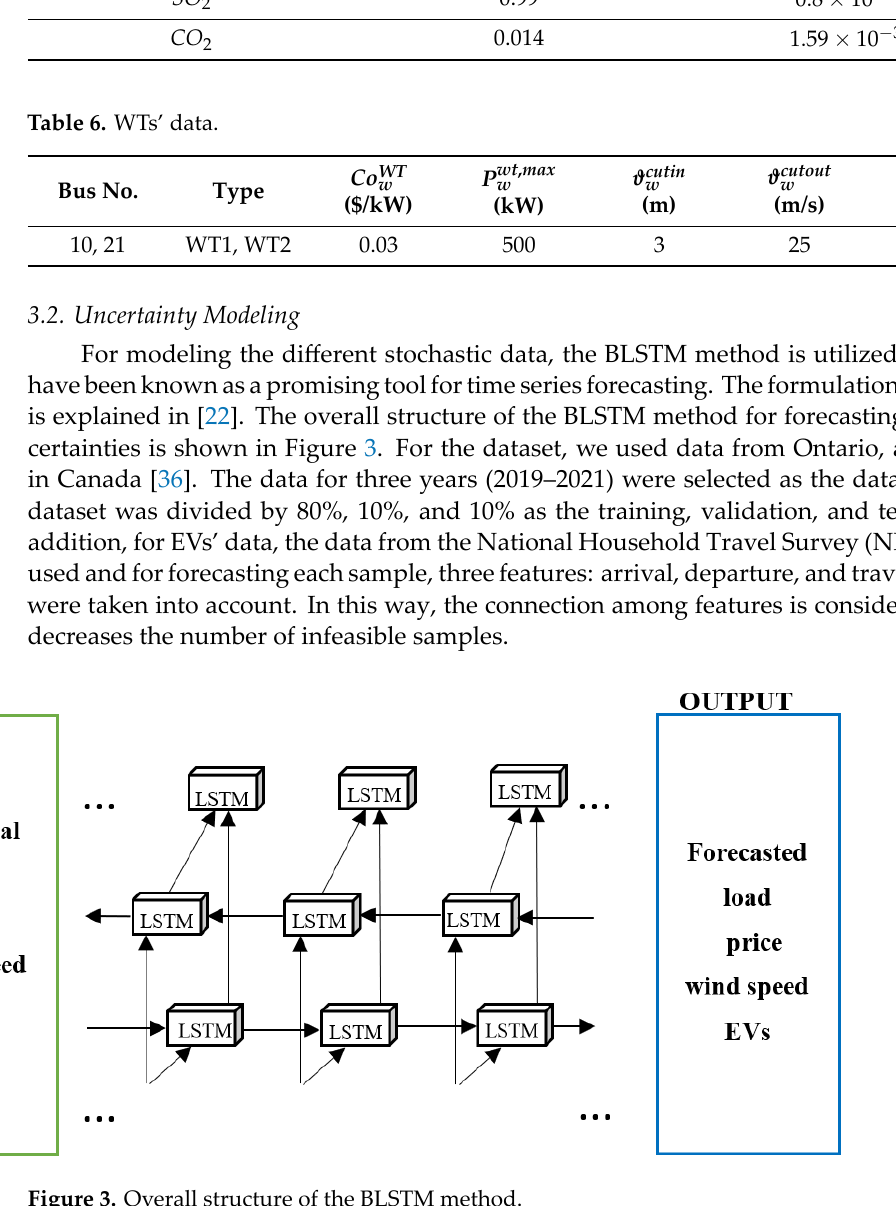
Figure 3. Overall structure of the BLSTM